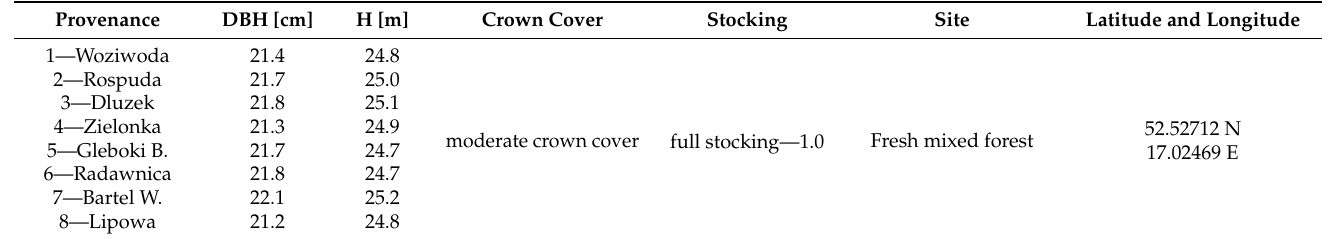
Table 1. The mean values of the model trees’ characteristics for each provenance and the characteris- tics of the experimental